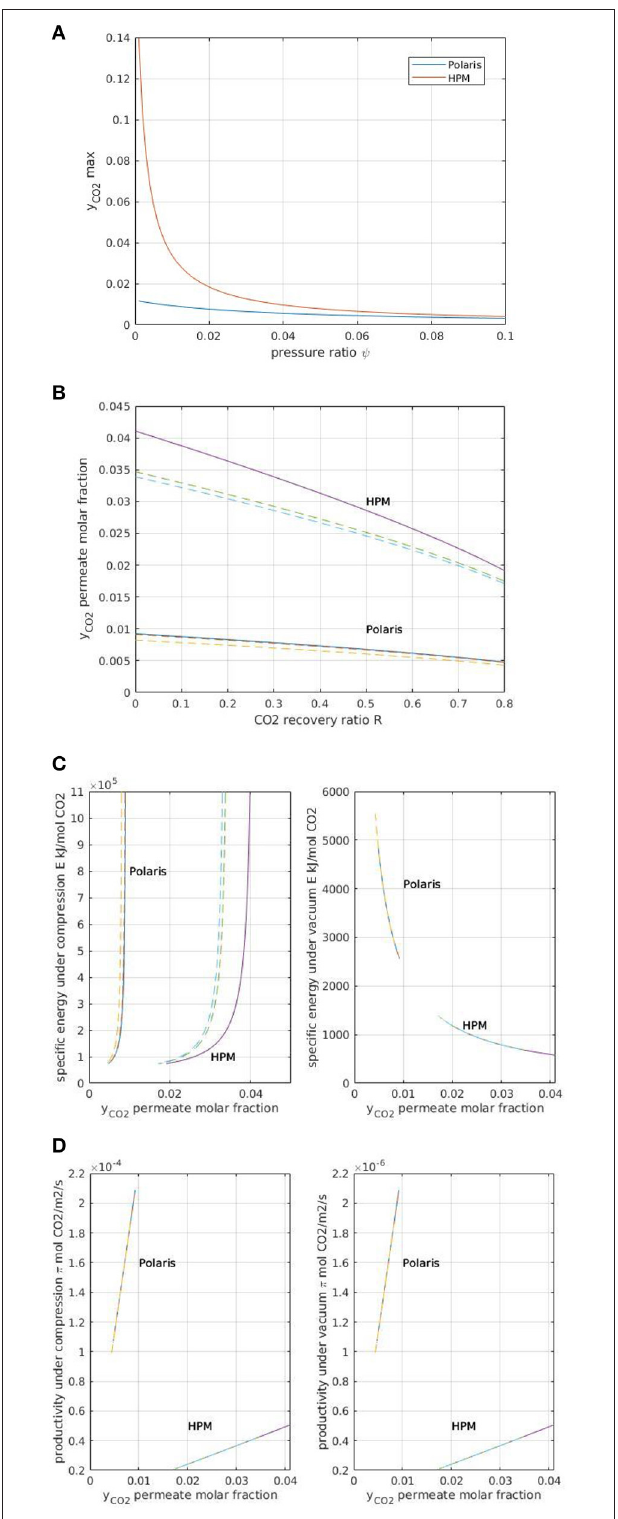
FIGURE 7 | (A) Maximal permeate purity y as a function of module pressure ratio ( ψ ) for an advanced membrane material HPM ( α = 680, P CO2 = 2,500 GPU) in comparison with Polaris membrane. (B) Purity (y) vs. recovery